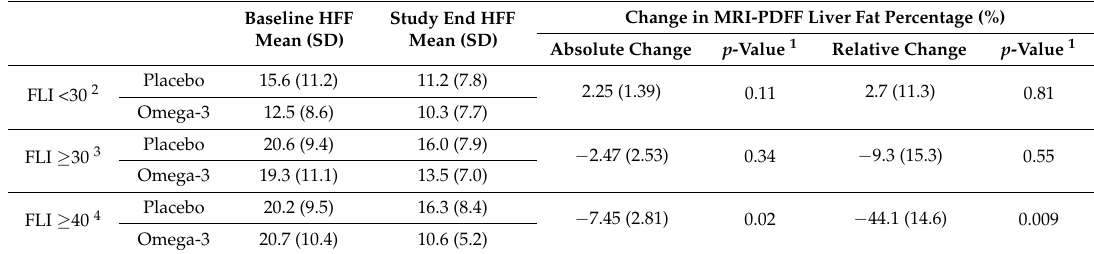
Table 5. Change in MRI-PDFF liver fat percentage after 24-week intervention with MF4637 stratified by baseline FLI